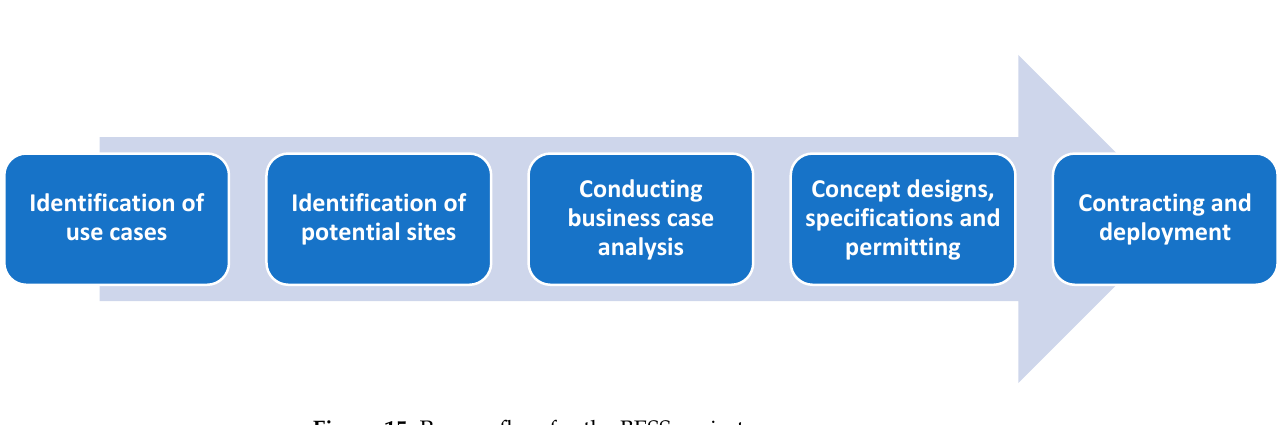
Figure 15. Process flow for the BESS project.